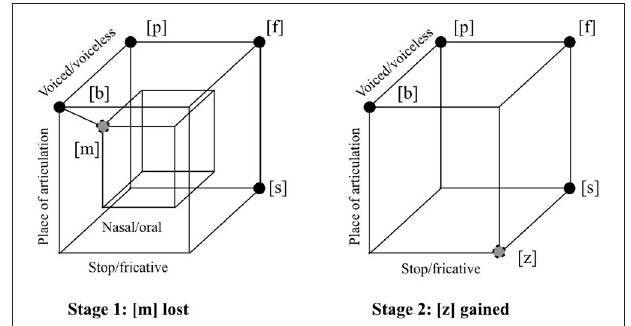
FIGURE 1 | Two stages in the history of a hypothetical language, illustrating the notion of economy as a geometric property of sound systems. Four idealized articulatory parameters are shown: place of articulation ([b], [p], [f], and [m] are made with constriction at the lips, while [s] and [z] are made by placing the tongue just above and behind the upper teeth); voicing ([b], [m], and [z] are made with vibration of the vocal cords, while [f] and [s] are without); nasal vs. oral airflow ([m] is made with the velum lowered so that air passes through the nose, while the other sounds are made with the velum raised, allowing airflow only in the mouth); and stop vs. fricative constriction ([b], [p], and [m] are made by totally blocking the flow of air through the mouth, while [f], [s], and [z] allow air to pass through a narrow opening and create noise). At Stage 1, the hypothetical language loses [m], increasing economy by eliminating one of the articulatory degrees of freedom of the inventory. At Stage 2, the language gains [z], increasing economy by making more use of the three remaining dimensions. The hypercube shown is a graph where the edges marked are between pairs of sounds of distance one in an idealized binary articulatory space. The remaining unsaturated edges of the interior and exterior cubes have also been added for clarity.